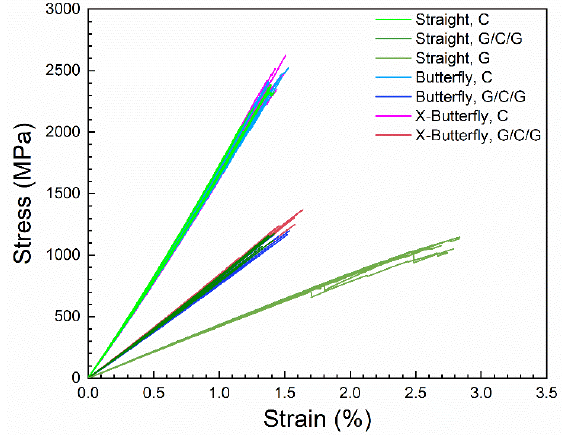
Figure 8. The seven groups of experimental stress–strain curves. The datasets is available in refer- ence [22].